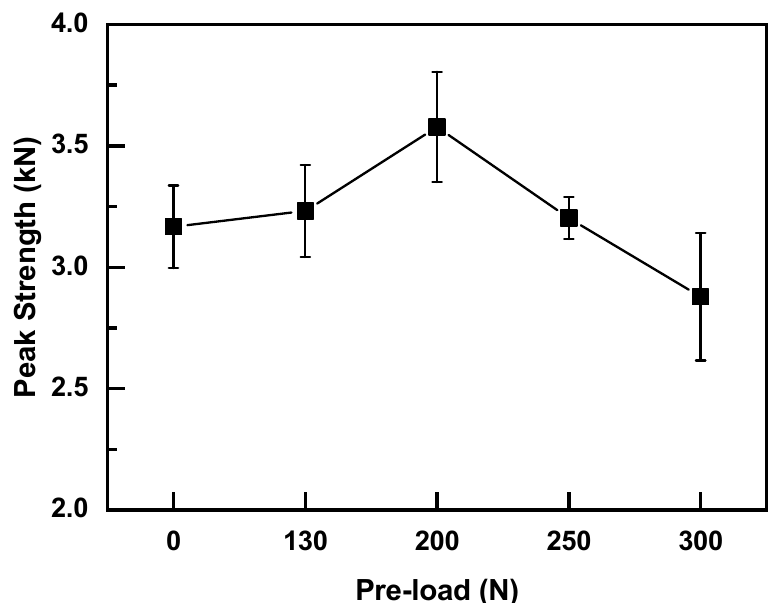
Figure 5. Effect of the preload force on strength of normal UWed joints (Welding pressure of 0.1 MPa and a welding time of 2.5 s).